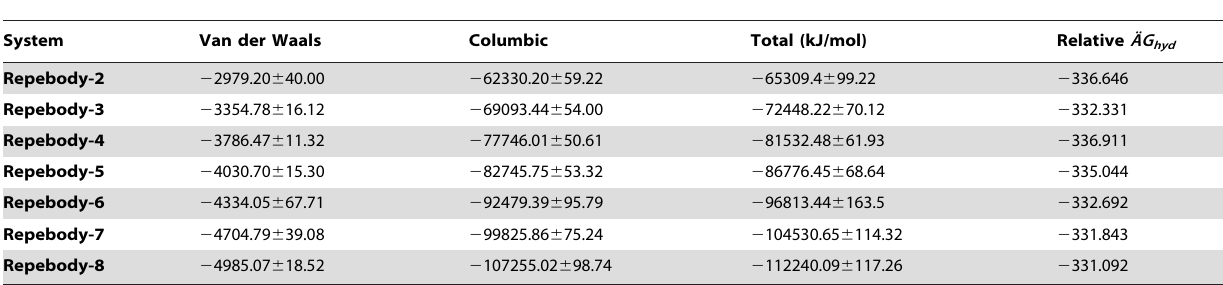
Table 5. Comparison of free energies of hydration for all seven repebodies.